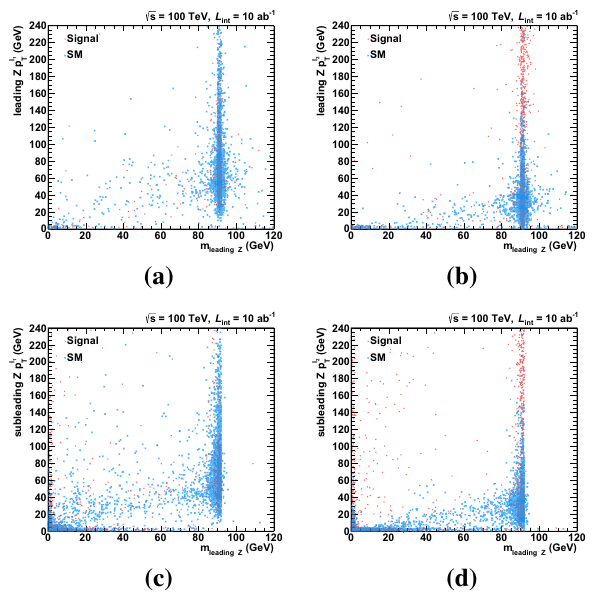
andplottedinFig.6.Thedistributionsbetweentwoleptonsof leading and sub-leading Z are in the first and second column. Each row corresponds to different decay channel aligned for 4 e , 4 μ and 2 e 2 μ , respectively. As seen in Fig. 6, the distri- butions are strongly peaked, (cid:13) R ( l 1 , l 2 ) ∼ 3, for signal and Fig. 5 Transverse momentum distributions of a leading lepton, b sub- background. This is due to the SM cross-section being ,domi- √ leadingleptonoftheleading Z bosonvsitsinvariantmassandtransverse ˆ s ∼ 2 M momentum distributions of c leading lepton, d sub-leading lepton of nated by the threshold region Z , where the Z-boson the sub-leading Z boson vs its invariant mass in the 2 e 2 μ channel momenta are small and the decay leptons tend to occur back- to-back. One can start to see anomalous couplings effects on > 20 GeV (20 GeV) and p (cid:2) 2 > 12 GeV (10 GeV) for ing p (cid:2) 1 the cross-section in the large Z boson transverse momentum T T (cid:2) 1 ,(cid:2) 2 > 5 GeV (5 electron (muon) and sub-leading Z having p region. The relative opening angle between the leptons con- T structing the Z-boson and Z-boson transverse momentum are inversely related due to the Lorentz boost, i.e. an increase in p Z causes a reduction in the opening angle [34]. The T